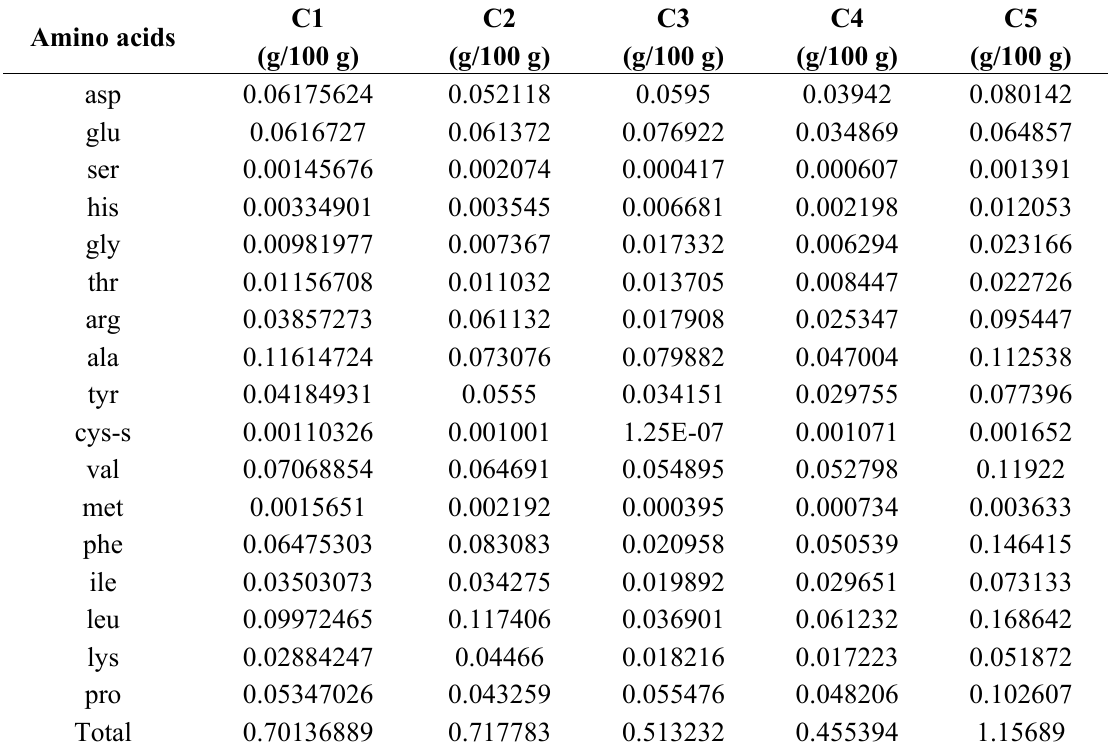
Table 4. The concentration of free amino acids (g/100